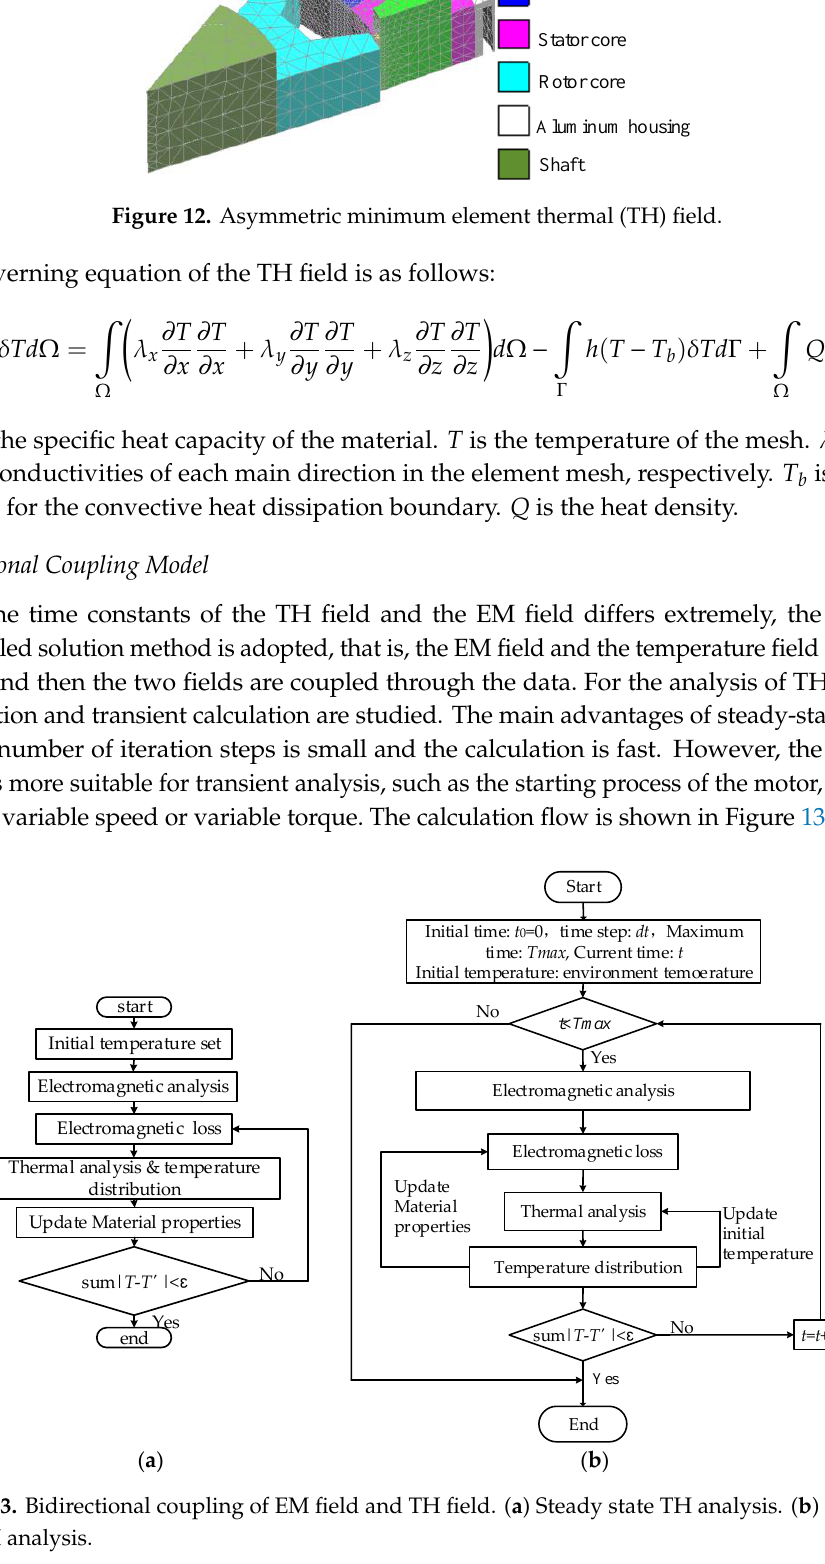
Figure 13. Bidirectional coupling of EM field and TH field. ( a ) Steady state TH analysis. ( b ) Transient state TH analysis.